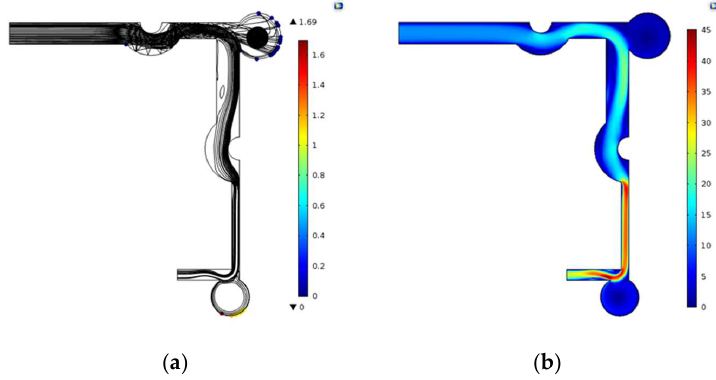
Figure 6. ( a ) Particle trajectory simulation in microfluidic chip; ( b ) simulation of velocity distribution in microfluidic chip (m/s) .